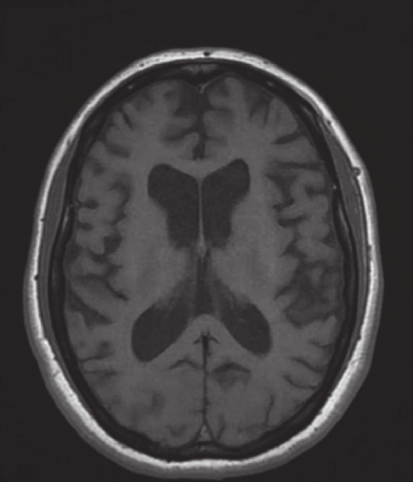
Figure 1: Axial T1-weighted MRI of the brain was performed on a 1.5Tesla scanner showing generalized moderate cortical atrophy for the patient’s